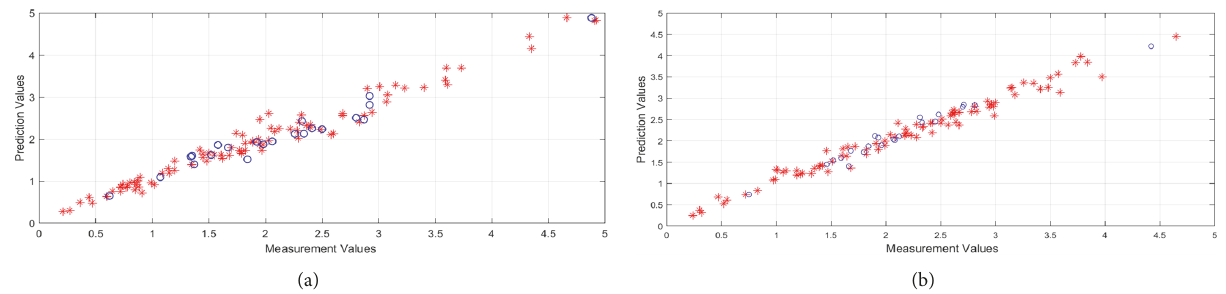
Figure 6: The square of correlation coefficient (R 2 ) and root mean square error of prediction (RMSEP) for TFC (a) and total antioxidant activity